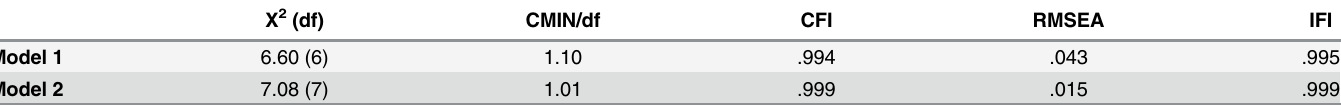
Table 3. Comparisons among pathways from 5-HTTLPR to perceived parenting and right frontal activation, using various measures of model